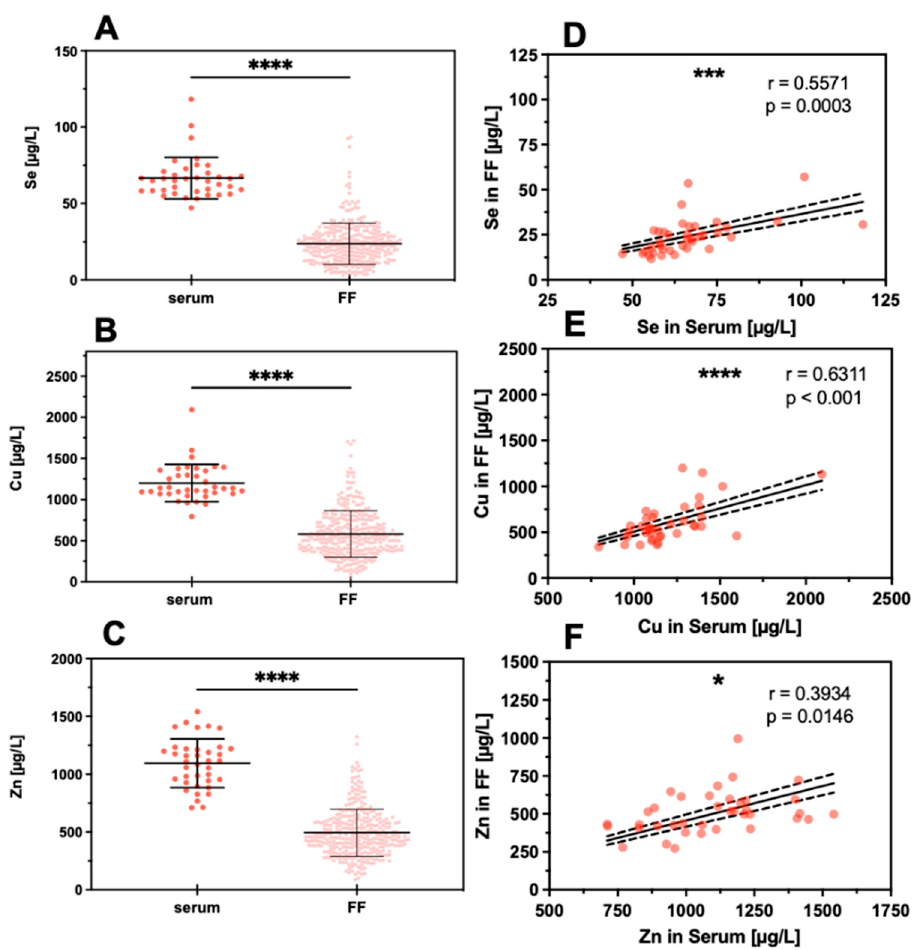
Figure 3. Comparison of TE concentrations in serum and FF samples. Trace elements were determined in serum samples (serum, n = 38) and follicular fluids (FF, n = 324 for Se, n = 330 for Cu, n = 330 for Zn). On average, the concentrations of ( A ) Se, ( B ) Cu, and ( C ) Zn were significantly lower in FF as compared to serum. Despite this difference, a significant linear positive correlation was observed between the FF and serum samples for ( D ) Se, ( E ) Cu, and ( F ) Zn. Samples were compared by paired t -test, and the significance shown for ( A – C ) was calculated based on the means of TE concentrations in the FF from the same woman; significance is indicated by * p < 0.05, *** p < 0.001, and **** p < 0.0001.